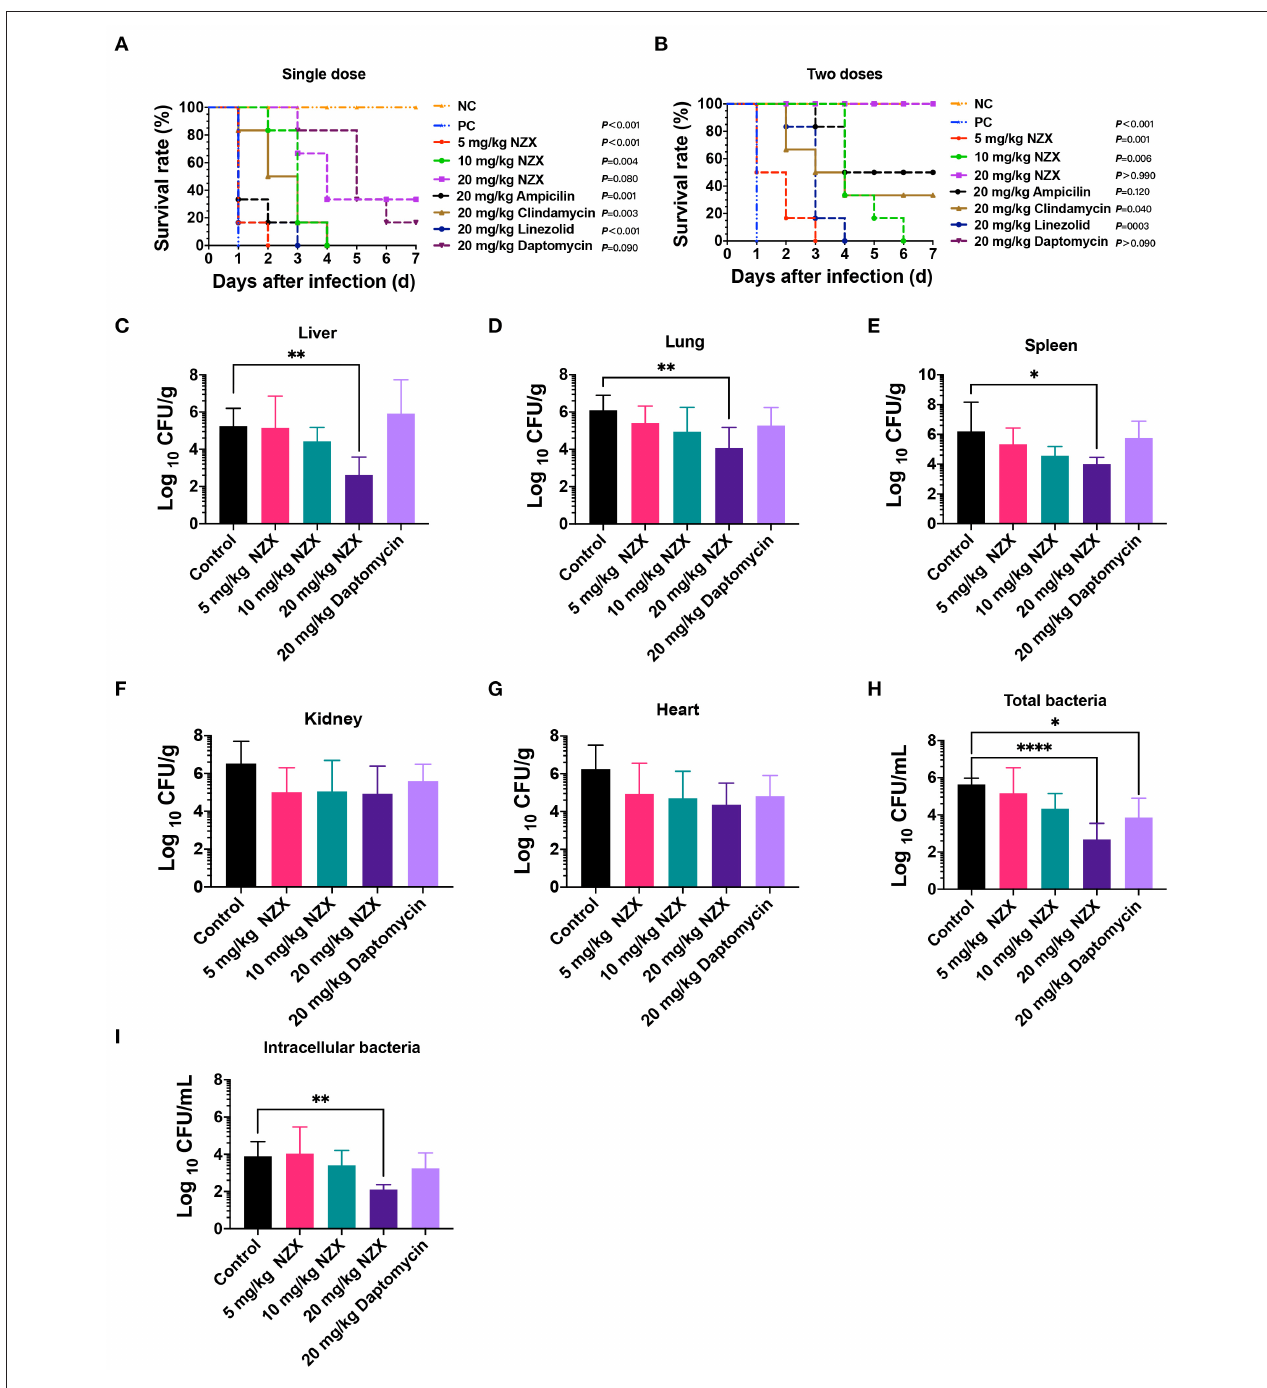
FIGURE 5 | Pharmacodynamics of NZX against S. aureus -induced mouse peritonitis model. (A,B) The survival rate of ICR mice ( n = 6) that were challenged intraperitoneally with S. aureus E48 (2 × 10 8 CFU/ml, 500 µ l) for 7-day post-infection. NZX at doses of 5, 10, and 20 mg/kg were administered intravenously single dose (A) (2h) and two doses (B) (2 and 8h) post-infection. The PC group: the infected but untreated mice; NC: the uninfected mice. (C–G) The bacterial burden of organ tissues and peritoneal fluid in the ICR mice infected intraperitoneally with S. aureus E48 (1 × 10 8 CFU/ml, 500 µ l). The bacterial counts in the liver (C) , lung (D) , spleen (E) , kidneys (F) , heart (G) , total bacteria (H), and intracellular bacteria (I) in the peritoneal fluid were analyzed after treatment with NZX (5, 10, and 20 mg/kg) or daptomycin (20 mg/kg) for 24h. The untreated mice were used as the negative control. The statistical difference was conducted by one-way ANOVA, with Tukey’s multiple comparisons test. Values are expressed as means ± SD ( n = 6); P -value < 0.05 was considered significant; * p < 0.05; ** p < 0.01; **** p < 0.0001.